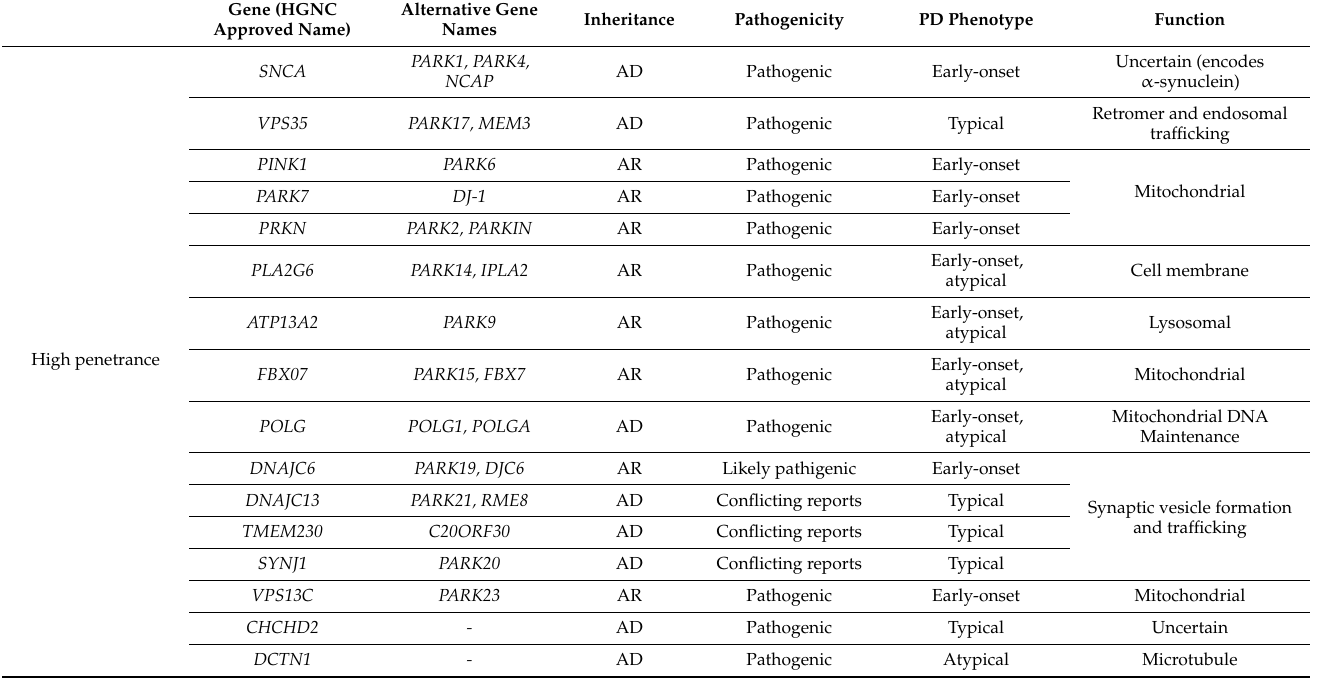
Table 1. Updated list of genes associated with PD. Reproduced with permission from Day JO and Mullin S, Genes (Basel); published by MDPI, 2021